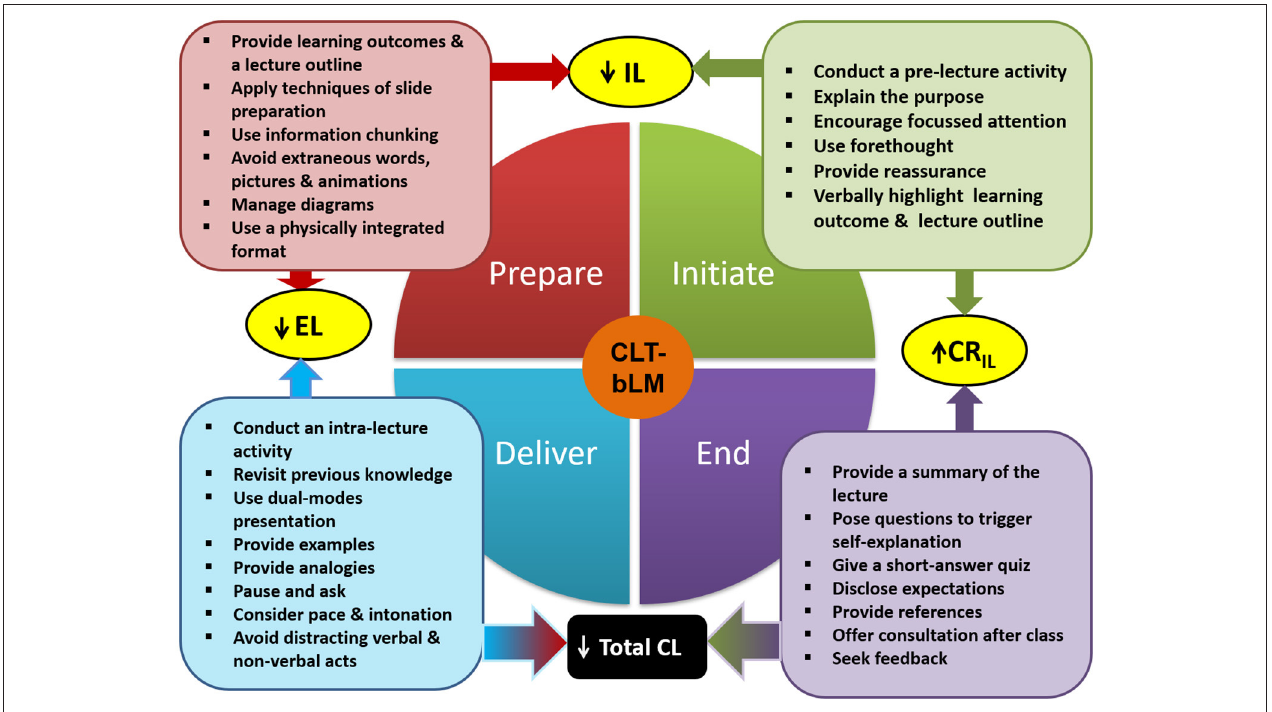
FIGURE 1 | The cognitive load theory-based lecture model [retrieved from